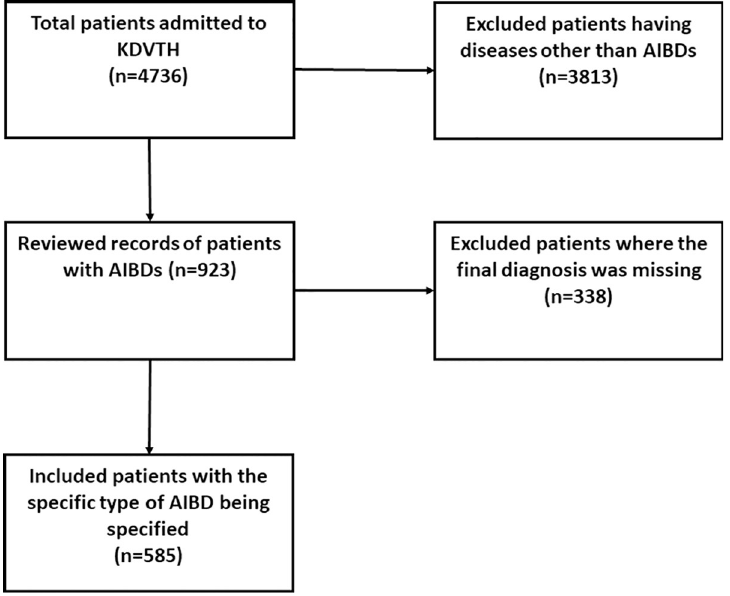
Fig 1. Patient selection flow chart. The inclusion of patient was a multi-step process. First, we identified patients with autoimmune bullous diseases (AIBD) from the total of patients in Khartoum Dermatological and Venereal Teaching Hospital (KDVTH) during the study period. Second, only patients with the specific diagnosis of an AIBD were included. https://doi.org/10.1371/journal.pone.0254634.g001 patients was 585 (Fig 1). Among the included patients, the male to female ratio was 1:1.6 (Fig 2). The cohort aged between two and 100 years, with a mean age of 45.2 ± 22.1 years. We found that only 52.7% of the patients went to the hospital in the first time the disease appeared, while 47.3% of the patients went to the hospital for a recurrent episode. In either